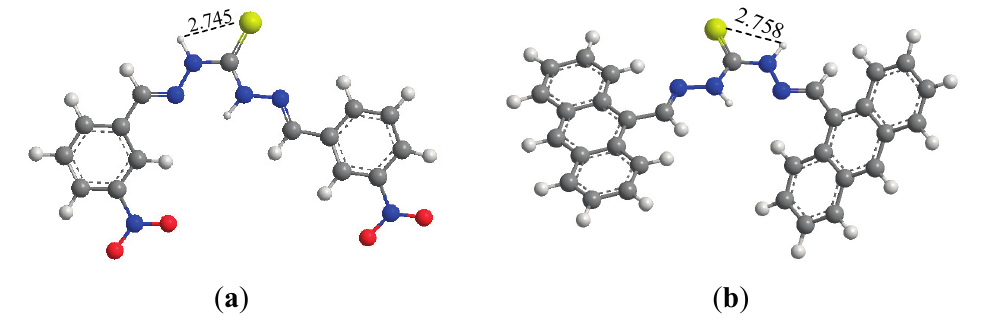
Figure 4. Optimized geometries of ( a ) Compound 1 and ( b ) Compound 3